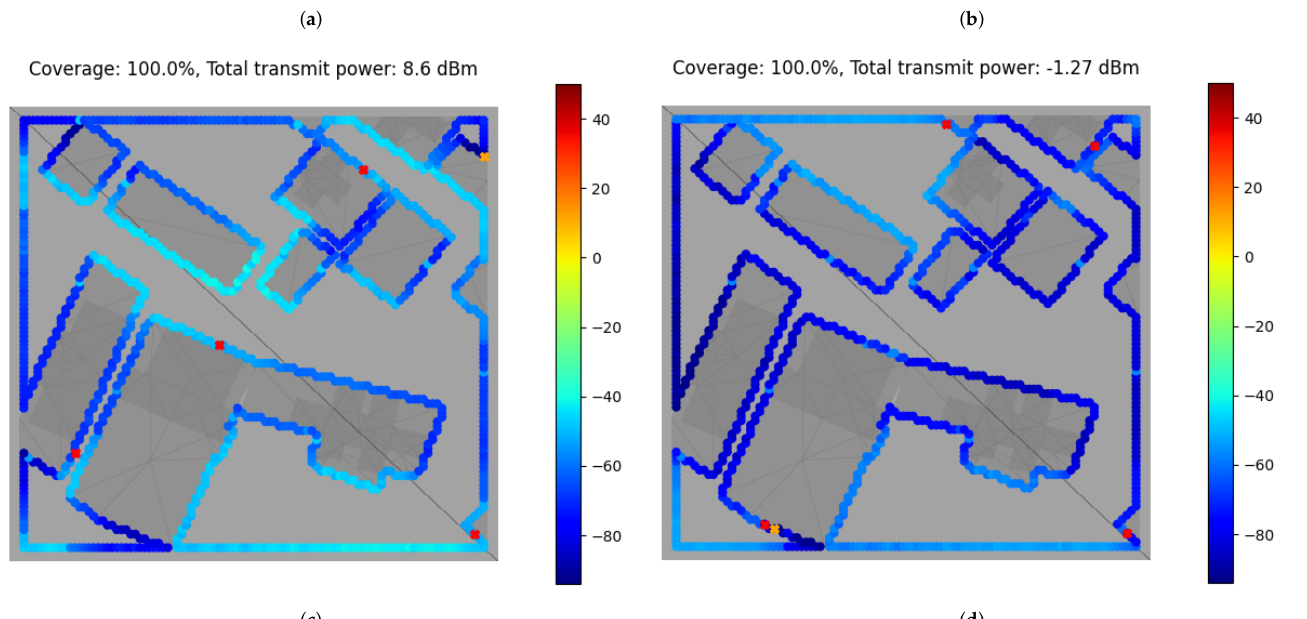
Figure 13. Heatmaps of the RTS-simulated received signal power at user locations when using the optimal AP placements generated using different channel models for map 5, using patch antennas. The red spots are the APs. The orange spots are the user locations that receive the overall lowest signal power. ( a ) Euclidean distance-based model; ( b ) Shortest path-based model; ( c ) Angular penalty-based model; ( d ) RTS-based